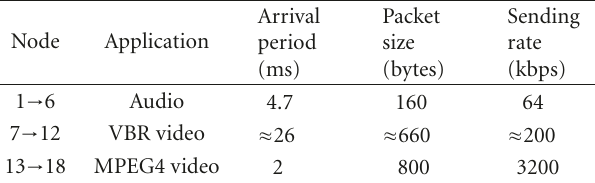
Table 2: Scenario 1 nodes and tra ffi c flows.